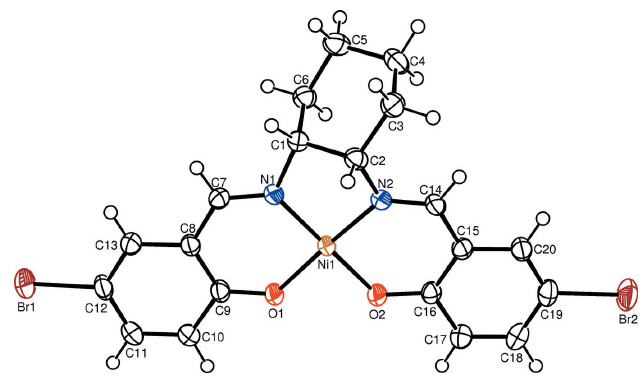
Figure 1 The molecular structure of the title compound showing the atom labelling and displacement ellipsoids drawn at the 50% probability level for non-H atoms.